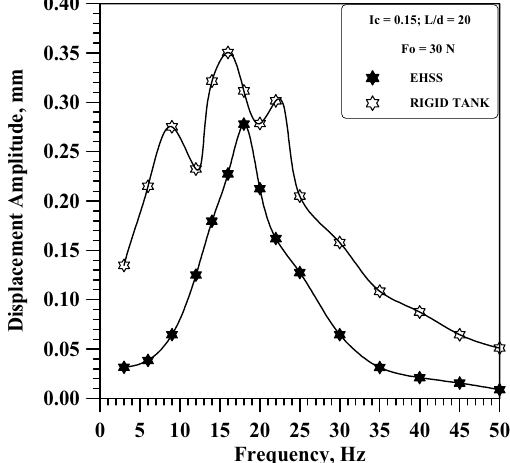
Fig. 5. Comparison of frequency response curve in rigid square tank and